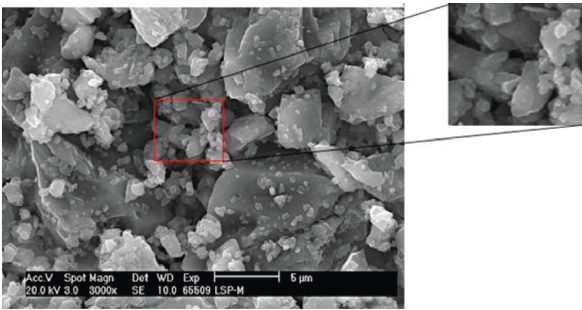
Figure 3: FESEM micrograph of